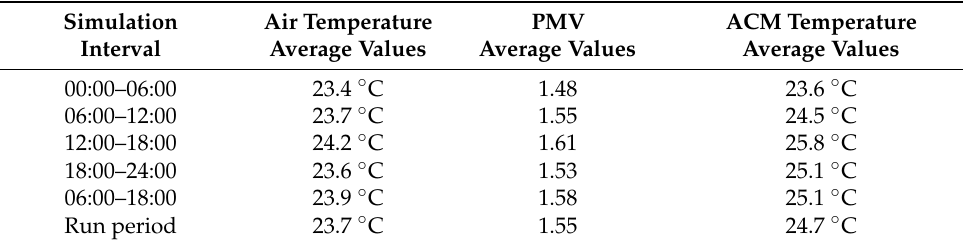
Table 5. Indoor environmental analysis data for the Materdei